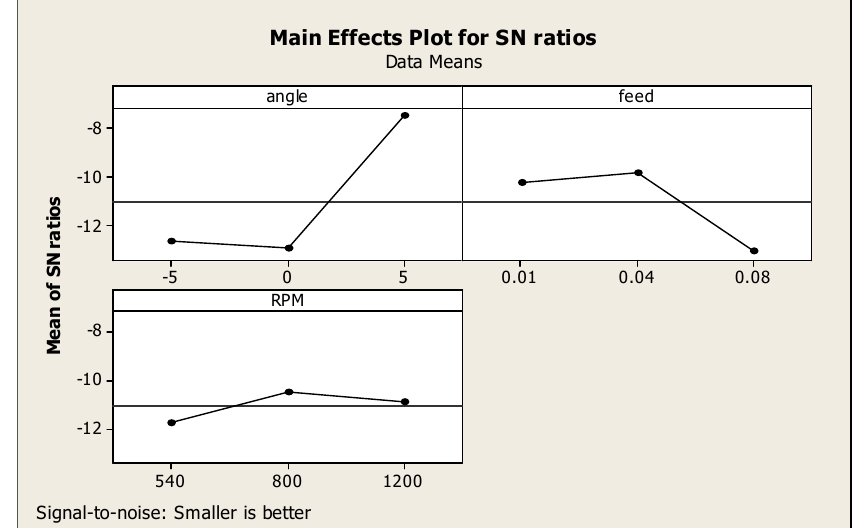
Fig. 7. Plot for signal to noise for bronze